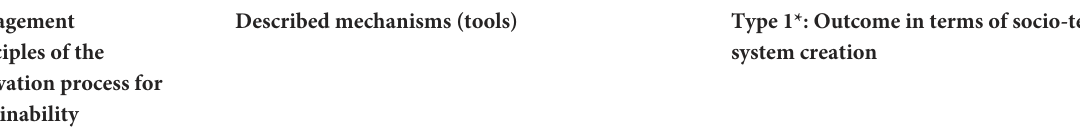
TABLE 3 Management principles within innovation process for sustainability that contribute to socio-technical system